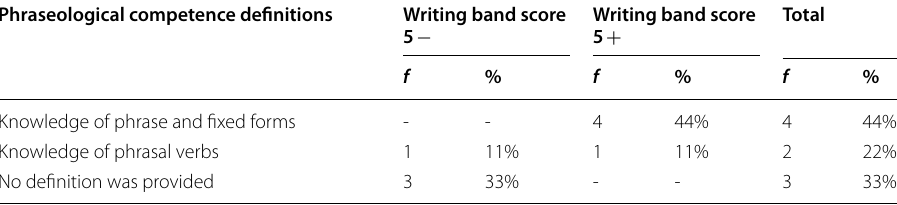
Table 9 Phraseological competence definitions as reported by IELTS candidates Phraseological competence